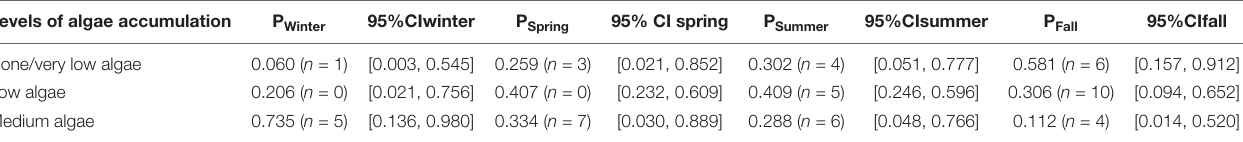
TABLE 1 | Shows results of RStudio ordinal logistic regression comparing fixed effects of season, and random effects of individuals, on accumulation of algae on the